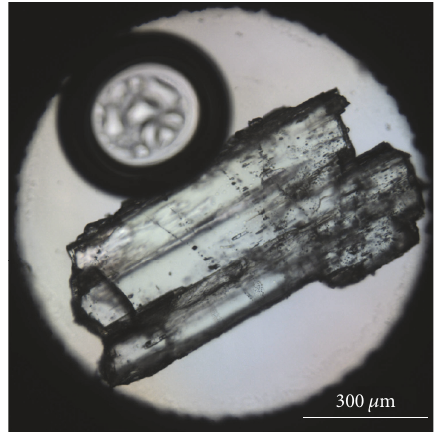
Figure 7: A photo showing a vapor bubble and a spodumene wafer in the sample chamber of